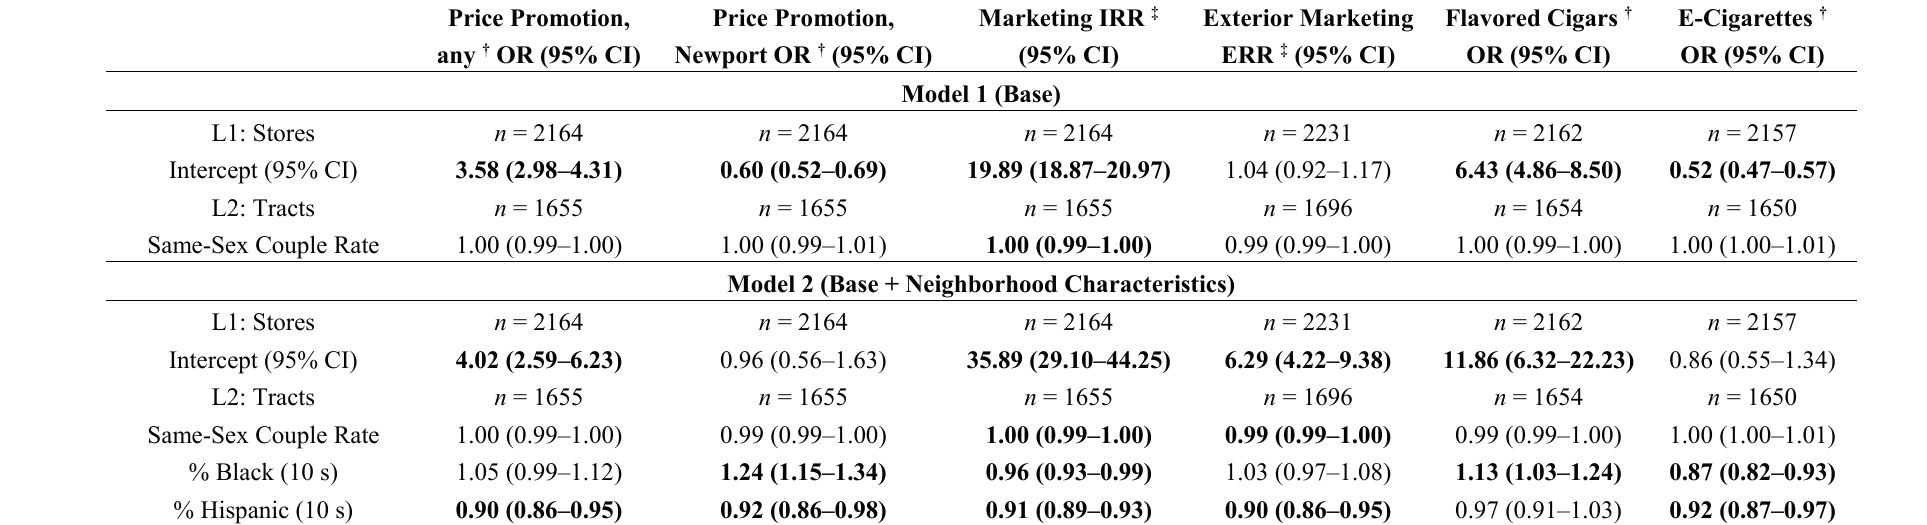
Table 4. Two-level models associating male same-sex couple rate with retailer tobacco marketing